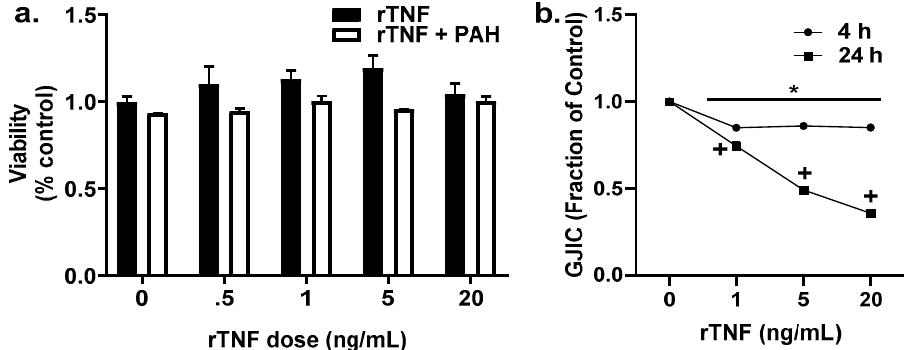
Figure 8. Recombinant TNF (rTNF) is not cytotoxic to C10 cells but does inhibit GJIC. ( a ) Cytotoxicity